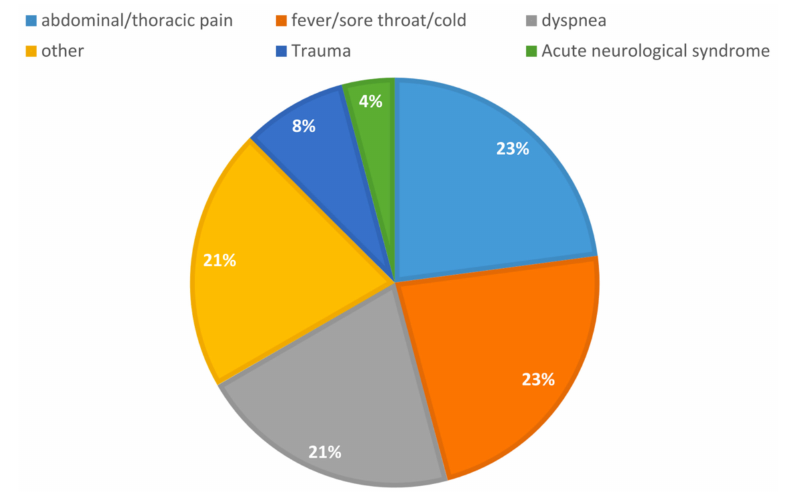
Figure 1. Causes for Emergency Department admission in the study